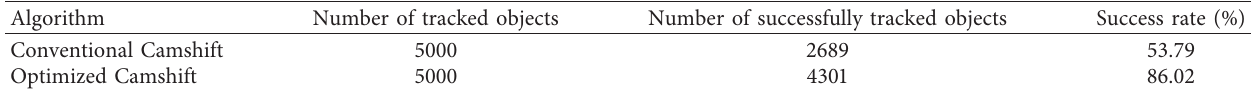
Table 2: The tracking success rate under severe occlusion of moving objects.